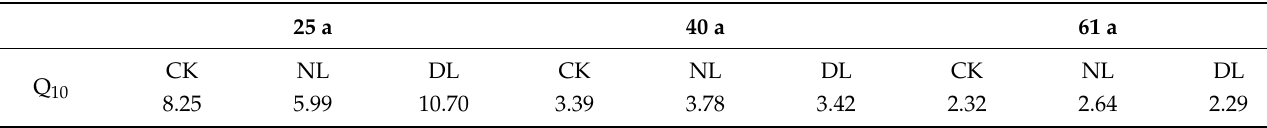
Figure 5. Fitted models of the soil respiration rate under litter manipulation against the soil temperature (at 10 cm, left) and the soil water content (at 10 cm, right) in different-aged Betula platyphylla forests of permafrost region, Northeast China. Stand ages included 25 ( a , d ), 40 ( b , e ) and 61 ( c , f ). Litter manipulation for each stand included NL (no-litter), DL (double litter) and CK (control litter). Table 3. The temperature sensitivity parameter Q 10 in different-aged Betula platyphylla forests of the permafrost region, Northeast China. Stand ages included 25 (a), 40 (b) and 61 (c). Litter manipulation for each stand included NL (no-litter), DL (double litter) and CK (control litter).